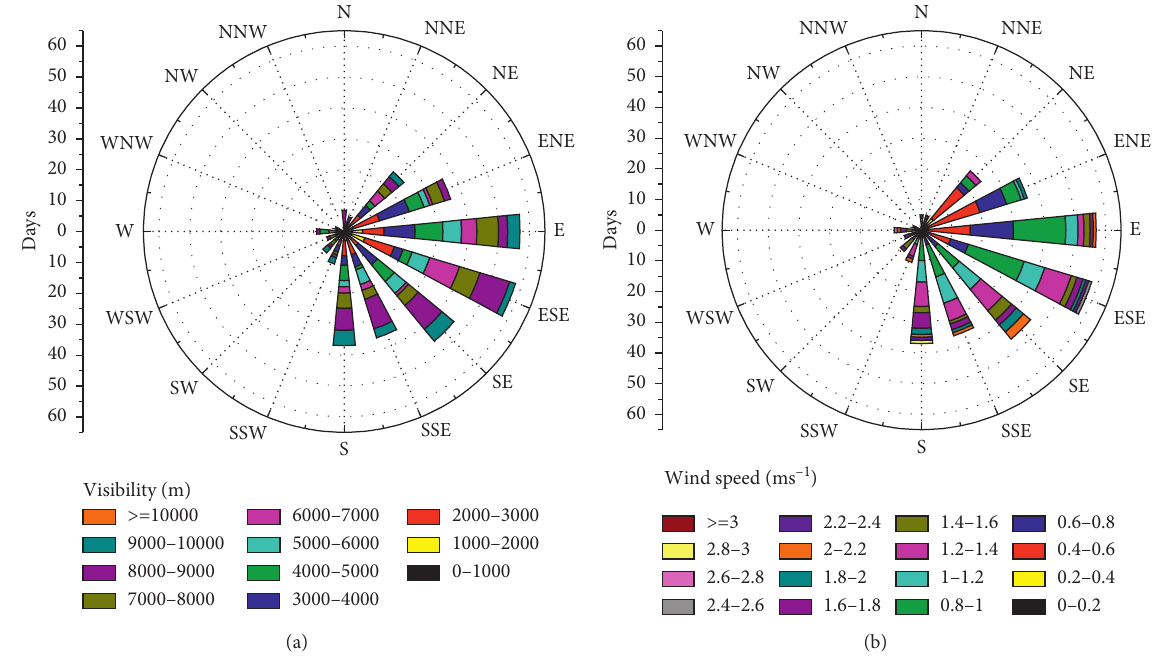
Figure 3: The wind rose diagrams of mean visibility (a) and wind speed